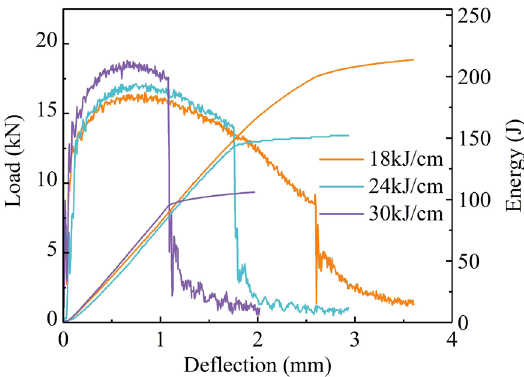
Figure 4. Oscillographic impact energy of test steel CGHAZ under different the welding heat